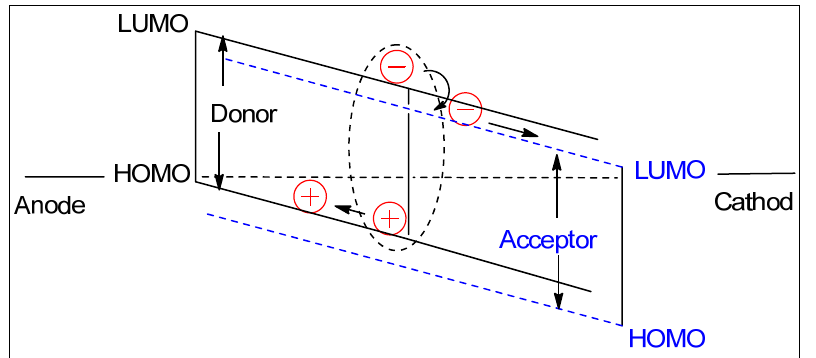
Figure 9. Schematic of a bulk heterojunction device. The donor component is blended with the acceptor component throughout the whole film. Consequently, photogenerated excitons can be separated into charge carriers at any place within a thin film.